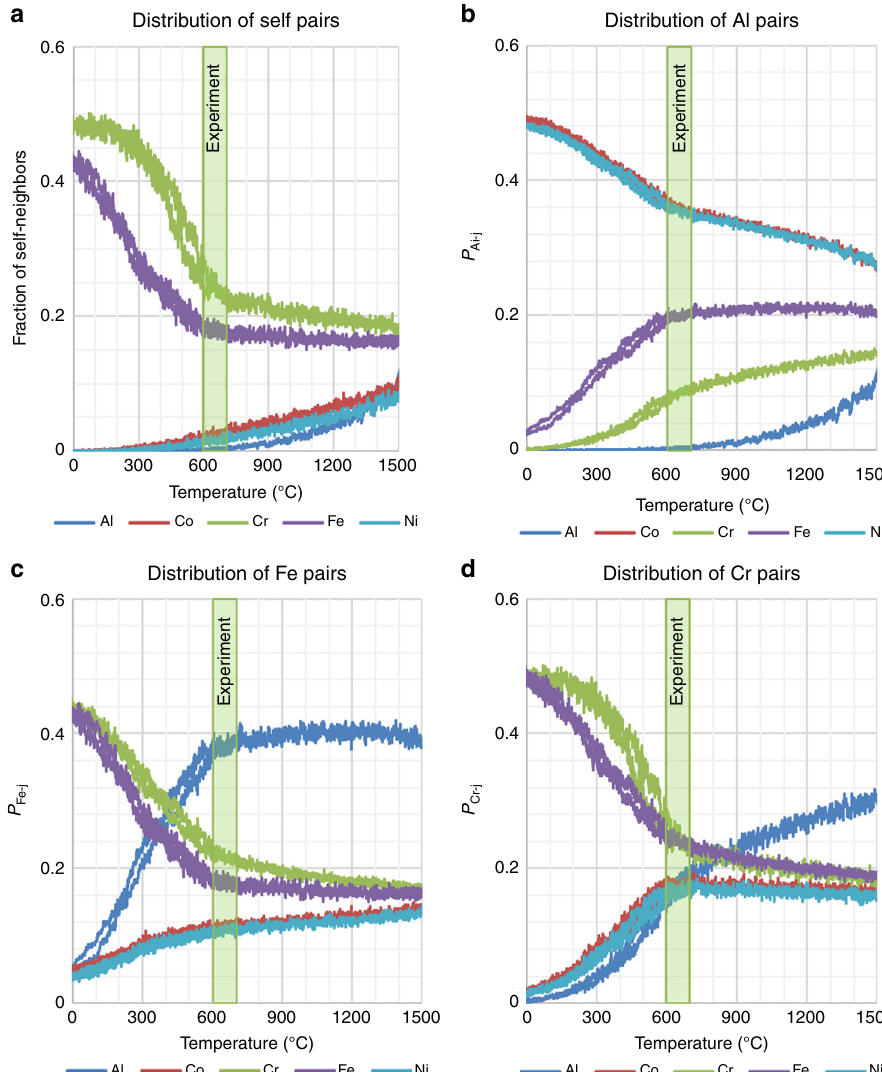
Fig. 5 Nearest-neighbor-pair correlations reveal transformations in Al 2 CoCrFeNi. The temperature range where microscopy shows a rapid change in microstructure (600 – 700 °C; Fig. 6) is highlighted by the shaded box in parts a – d . a The self-pair probabilities, P ii , reveal two groups of elements, the strongly ordering Al, Co, and Ni, with vanishing self-neighbor probability at low temperatures that indicates strong ordering, and the disordered/ segregating Cr and Fe. The strongly ordering and disordered/segregating groups play key roles in the fi rst and second steps, respectively, of the cooling transformation. b The P Al- j indicate that Co and Ni are the strongly preferred neighbors of Al. While the fraction of Fe neighbors is nearly constant above 600 °C, this trend drops off sharply below this temperature. c The P Fe- j show a distinct change near 600 °C, consistent with segregation from the Al-rich matrix. d The P Cr -j show a similar trend as the P Fe -j , except that the Cr-Al-pair probability is